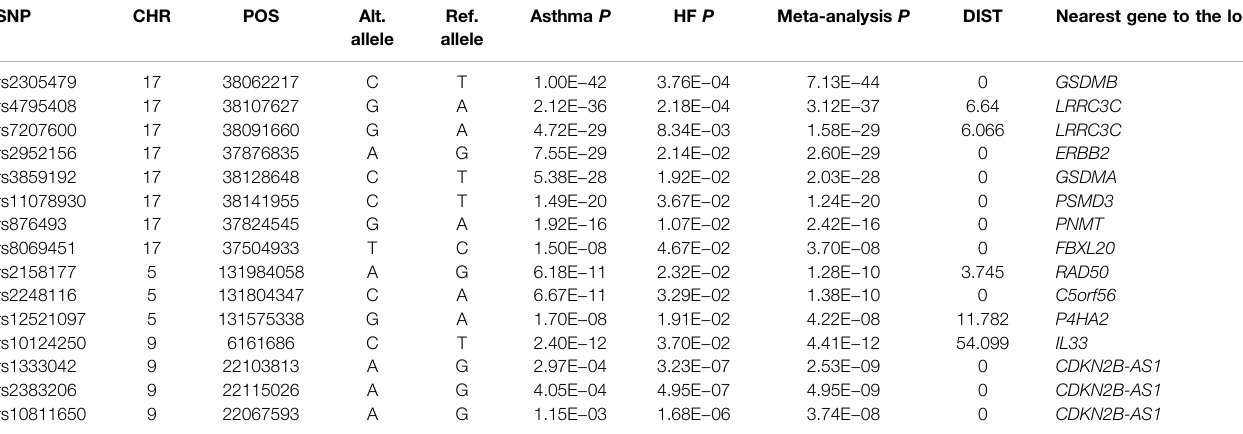
SNP, single-nucleotide polymorphism; CHR, chromosome; POS, position of the clumping region on the chromosome; Alt. allele, alternative allele; Ref. allele, reference allele; HF, heart failure;DIST:thesmallest(inabsolutevalue)signeddistanceofthenearestgenetotheloci.Thethreshold P oflinkagedisequilibriumis5e − 5.Clumpresultsuseadistanceof500 kband R 2 of 0.4. SNP positions are reported according to Build GRch37.